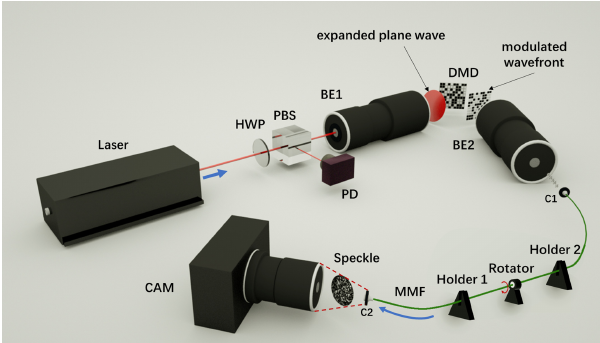
Fig. 1. Schematic diagram of the specklegram twist sensor: C 1 and C 2 , ¯ber collimator; CAM, digital camera; BE, beam ex- pander; DMD, digital micro device; HWP, half-wave plate; MMF, multimode ¯ber; PBS, polarized beam splitter; PD,